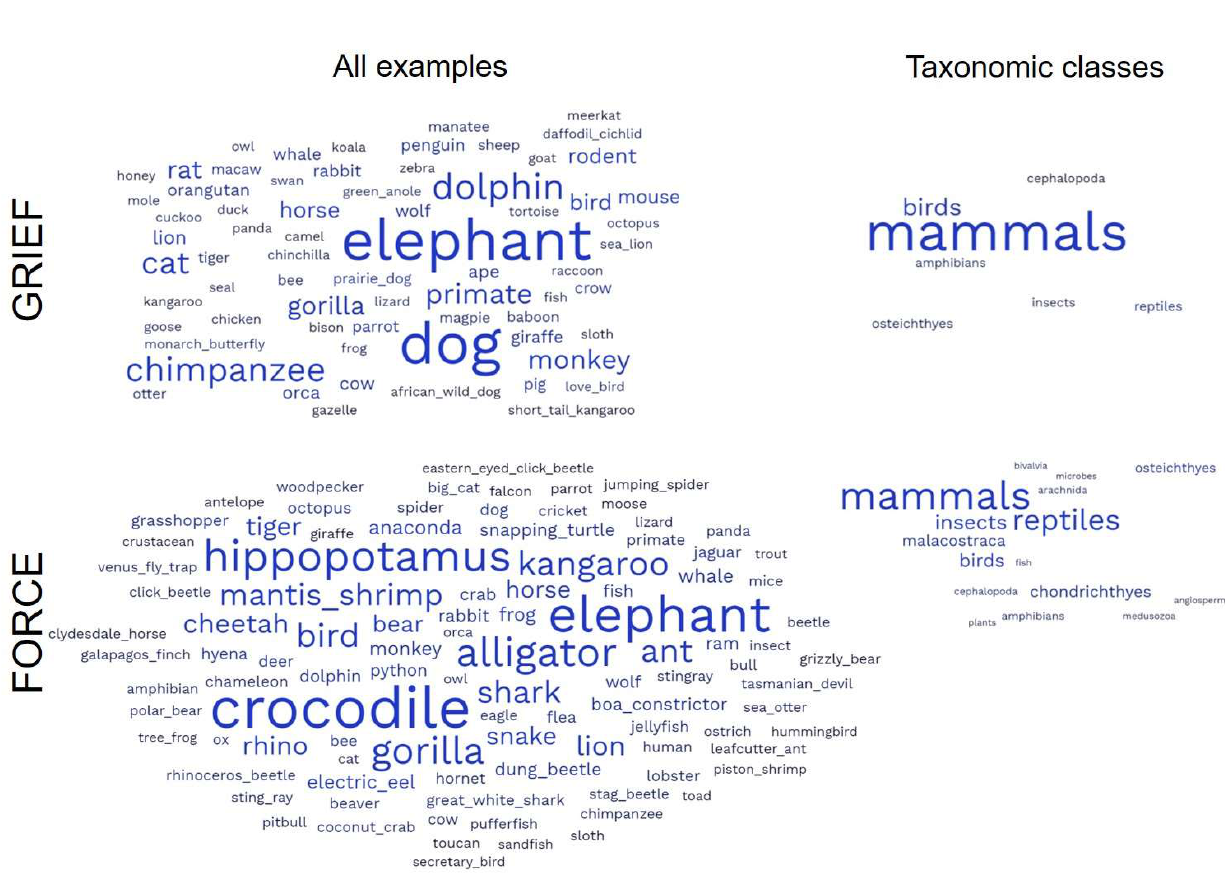
Figure 2. Word clouds for the “grief” and “force” assignments made from all student responses and from the list of taxonomic classes represented in each student’s set of examples. Word size corresponds to frequency across all student responses. Not surprisingly, responses to the “force” prompt had a greater diversity of taxonomic classes represented, and fewer of the responses were mammals (mammal bias) compared to the “grief” prompt. Raw frequency data can be found in [50] under an open access license.